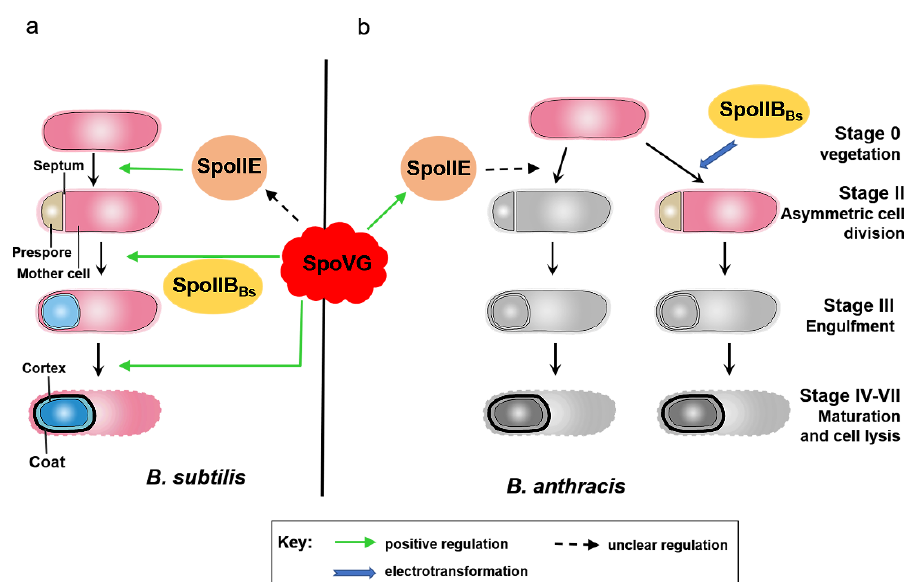
Figure 7. Schematic representation of regulatory pathways and their effectors in B. anthracis and B. subtilis based on the results of this study. ( a ) In B. subtilis , SpoVG is involved in spore formation at multiple stages (asymmetric division, engulfment, and cortex formation). Combined mutation of spoIIB and spoVG prevents spore formation at the engulfment stage. ( b ) In B. anthracis , the Δ spoVG mutant shows no asymmetric septum formation. SpoVG positively modulates spore formation through SpoIIE. B. subtilis SpoIIB (SpoIIB Bs ) partly restored spore formation in the B. anthracis Δ spoVG strain at the engulfment stage of sporulation.